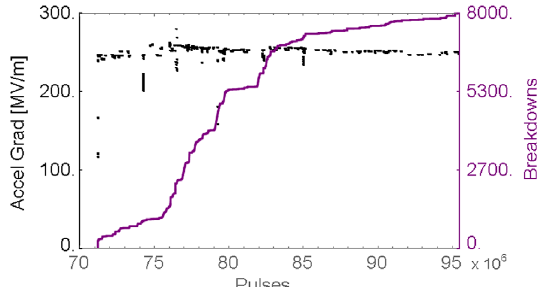
FIG. 10. Purple is the accumulated breakdowns and black the calculated average accelerating gradient (average over t 1 to t 2 ) from the nonlinear model. This is a zoom in of Fig. 9(b) for the time period where the BDR was